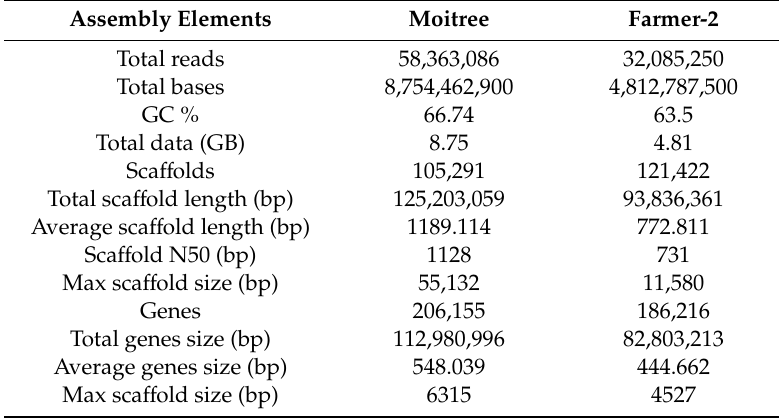
Table 4. Read count summaries, assembly statistics, and gene prediction statistics between two lentil